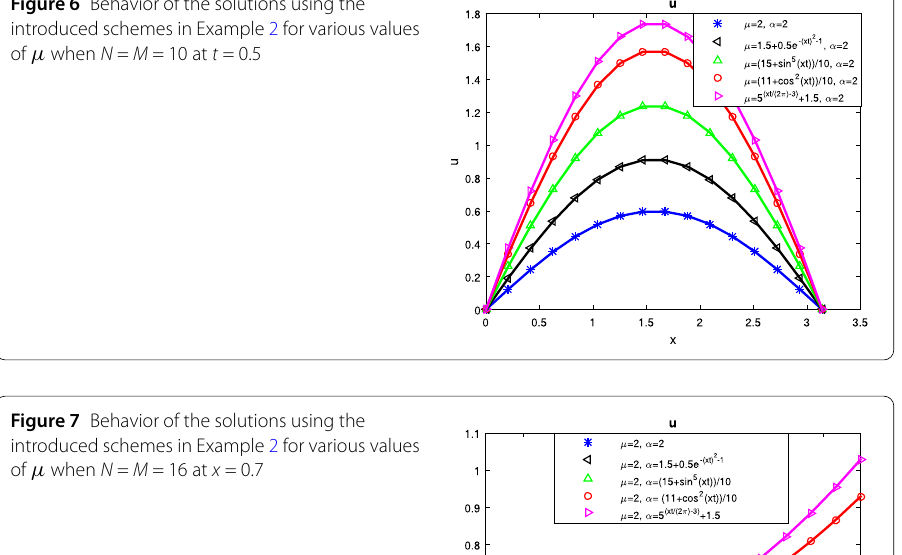
Figure 7 Behavior of the solutions using the introduced schemes in Example 2 for various values of μ when N = M = 16 at x = 0.7